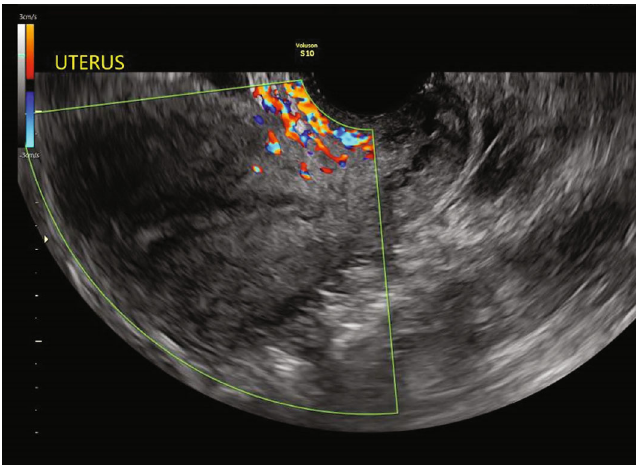
Figure 1: Transvaginal ultrasound performed in clinic for evaluation of abnormal uterine bleeding. Endometrial thickness was noted to be